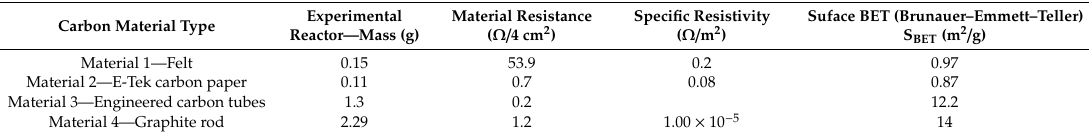
Table 1. Physical and electrical properties of the four di ff erent experimental anode carbon